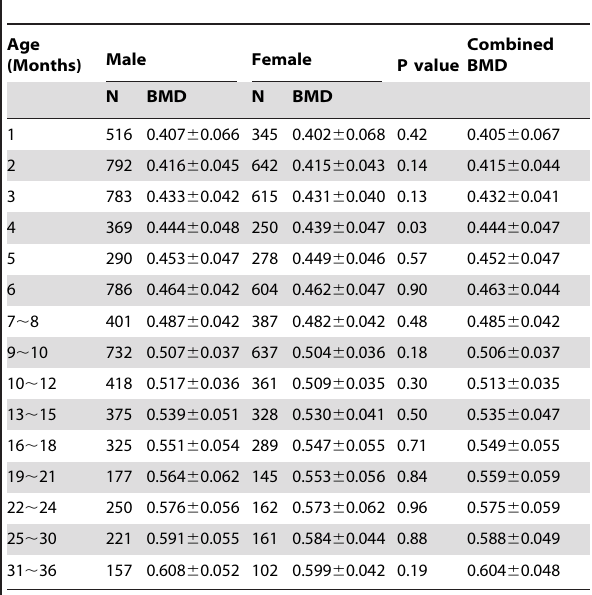
Table 1. Clinical characteristics of 11,898 healthy reference Chinese children aged 0 , 3 years.